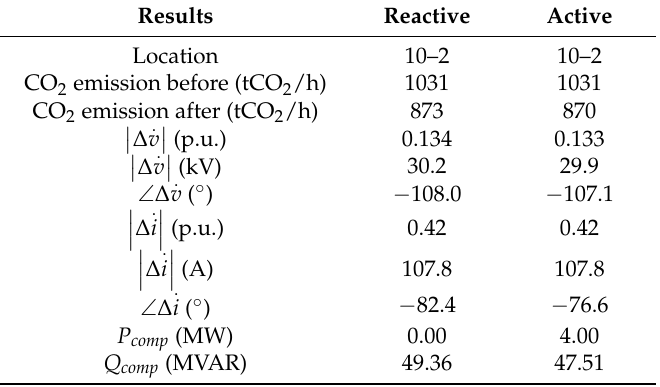
Table 8. Optimization results for the application of reactive combined FACTS.